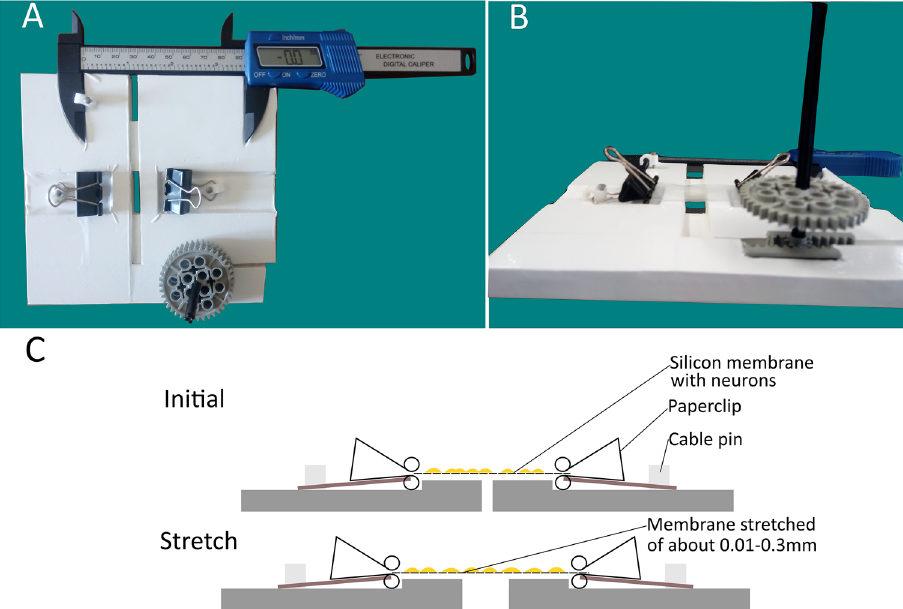
Figure 4. The Bioreactor for in vitro Neurodynamic treatment model. ( A ) The device consists of three 3 mm Forex layers covered with UV-resistant D-c-fix® and divided into two parts puzzled possibly to be driven horizontally by the user to induce neurodynamic treatment protocols. ( B ) Type I collagen pre-coated silicon membrane cut in rectangular shape is clipped into the device and the stretch is administered by hand when turning the wheel to the right. ( C ) The device and the membrane are shown in cross-section. Initially, the membrane is positioned in the device and clipped. To induce the stretch, the wheel is turned to the right, stretching uniaxially the membranes with constant gravity force. Stretch is repeated by turning the wheel to the left until the initial position is reached and turned again to the right with different repetitions depending on the treatment protocols.